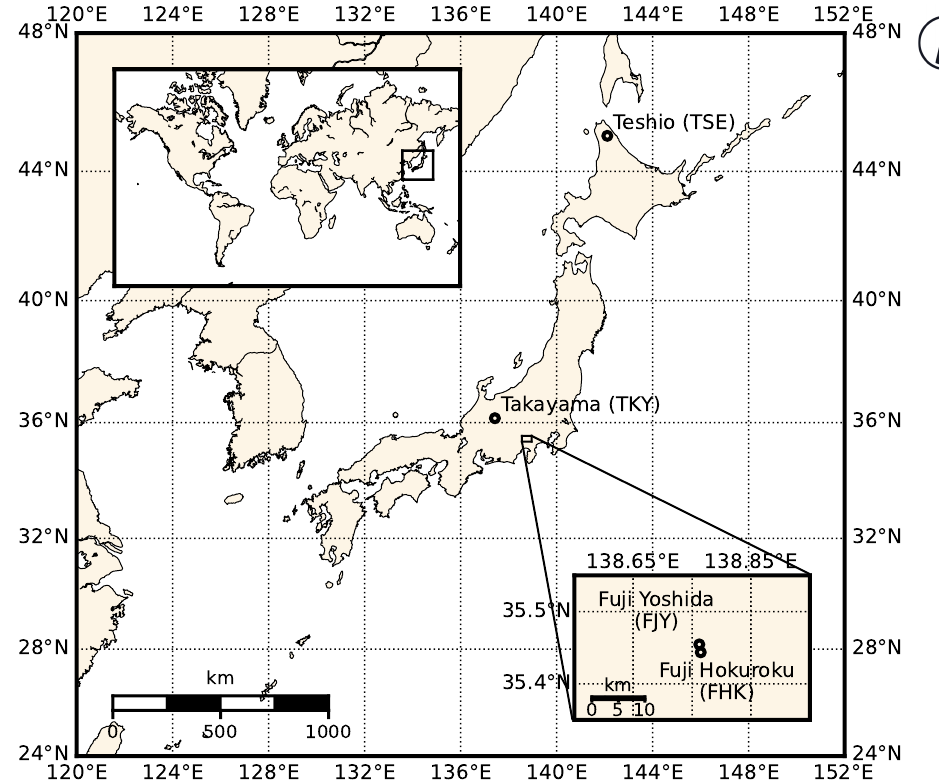
Figure 1. Locations of the four study sites where in situ data were